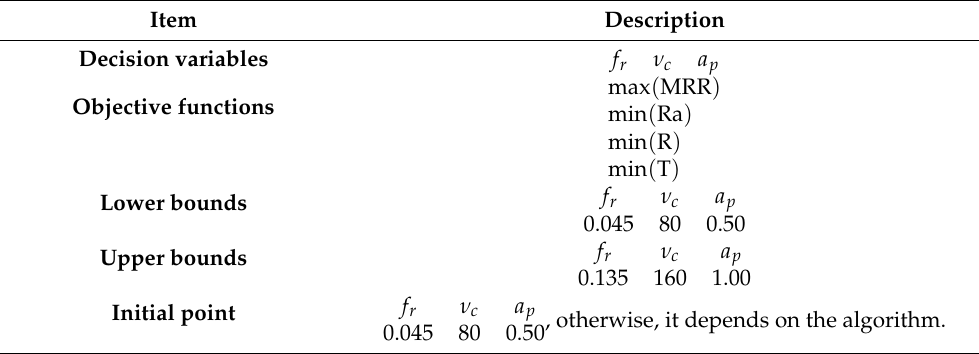
Table 6. Optimization model